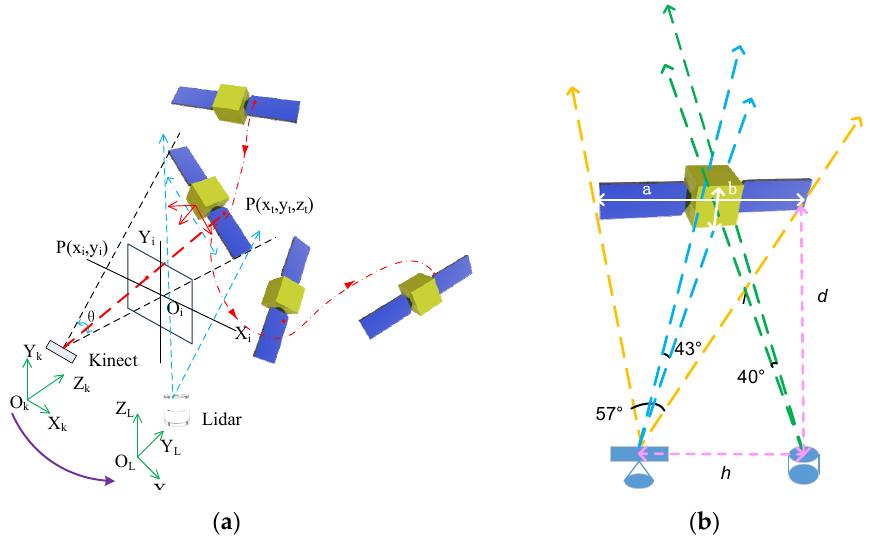
Figure 2. ( a ) Measurement system. ( b ) Schematic diagram of the FOV for two sensors.